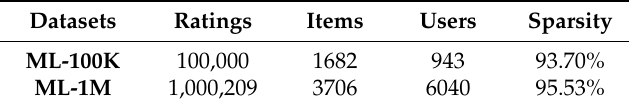
Table 1. Statistics of the evaluation